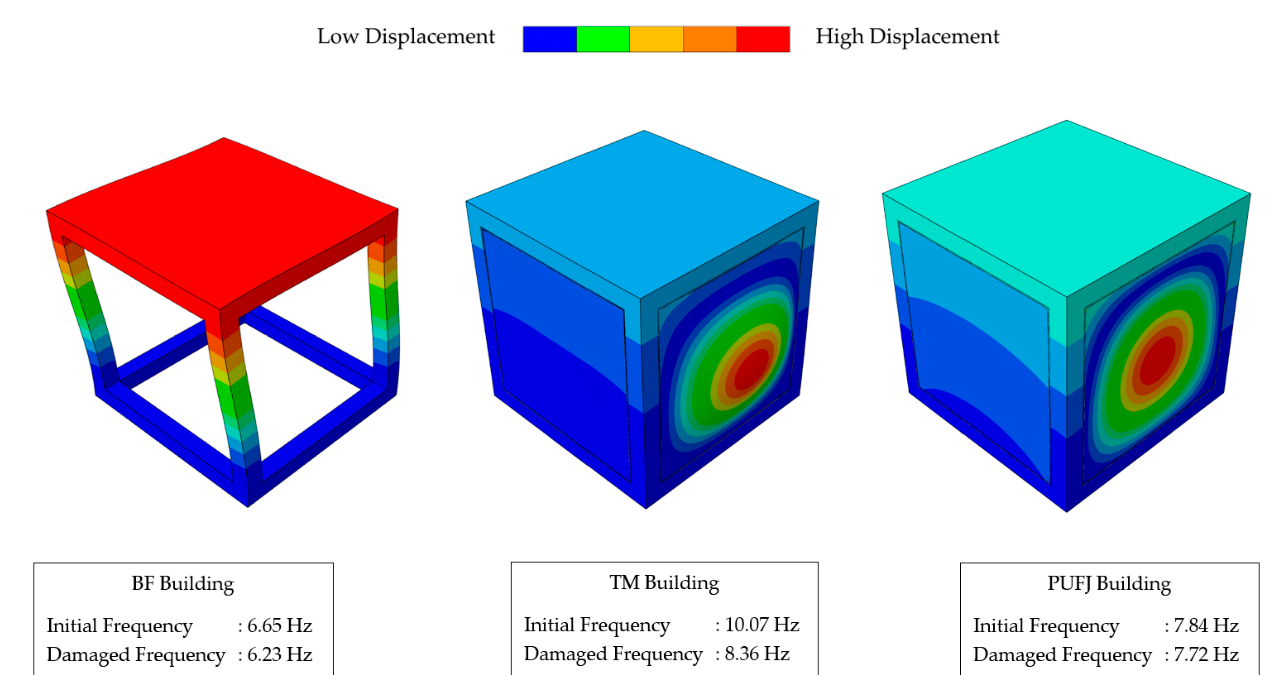
Figure 24. Mode shapes and frequencies of the buildings.